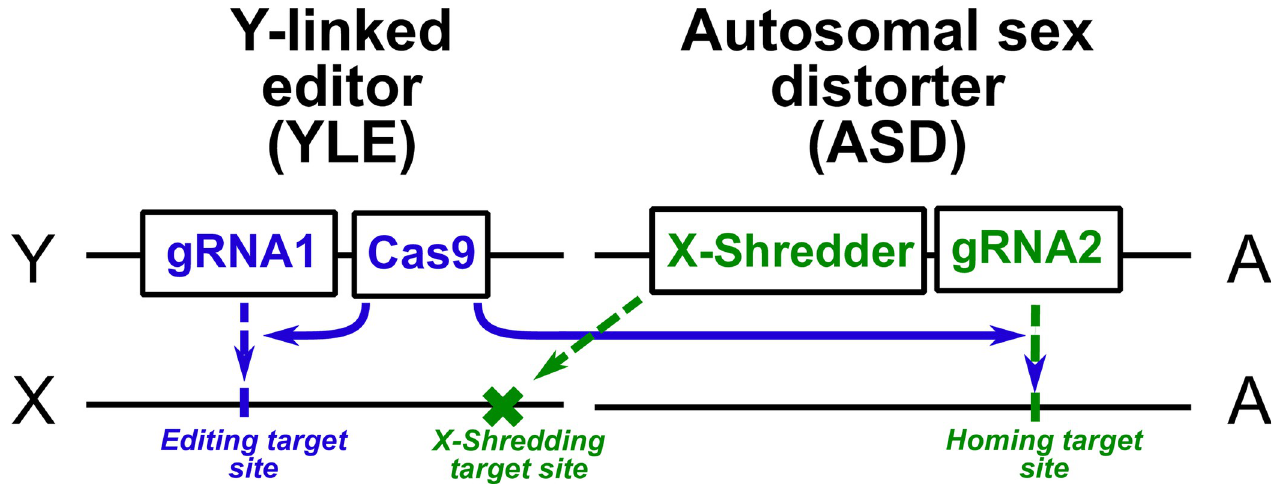
Fig 1. The proposed genetic constructs. We model a Y-linked editor (YLE) that targets an X-linked locus such that female offspring die and an autosomal sex distorter (ASD) that in males disrupts transmission of the X chromosome (thereby favouring transmission of the Y), and that, in the presence of the YLE, shows drive via the homing reaction. More specifically, we model the YLE as consisting of a germline-expressed Cas9 and ubiquitously expressed gRNA (together responsible for the editing), and the ASD as consisting of a X-shredder nuclease expressed during male meiosis (responsible for the sex distortion) and a ubiquitously expressed gRNA that, in the presence of the Y-linked Cas9, allows the ASD to home.